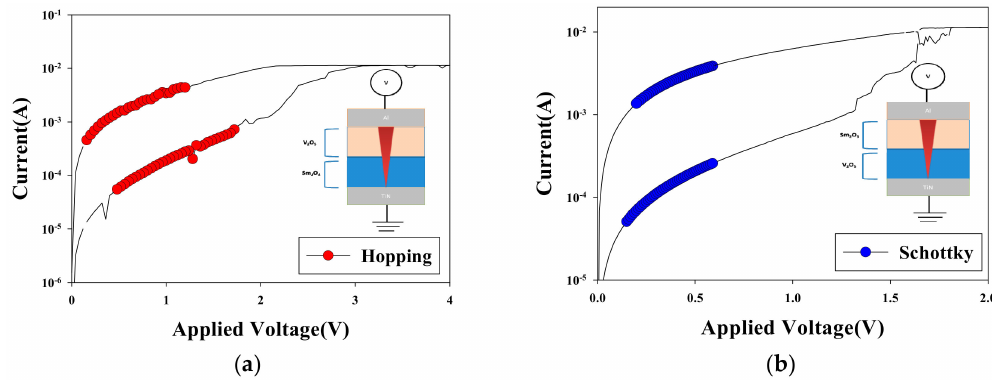
Figure 6. The electrical conduction mechanisms and metal filament path models for the Al / Sm 2 O 3 / V 2 O 5 / TiN / SiO 2 / Si and Al / V 2 O 5 / Sm 2 O 3 / TiN / SiO 2 / Si devices when a positive bias is applied.